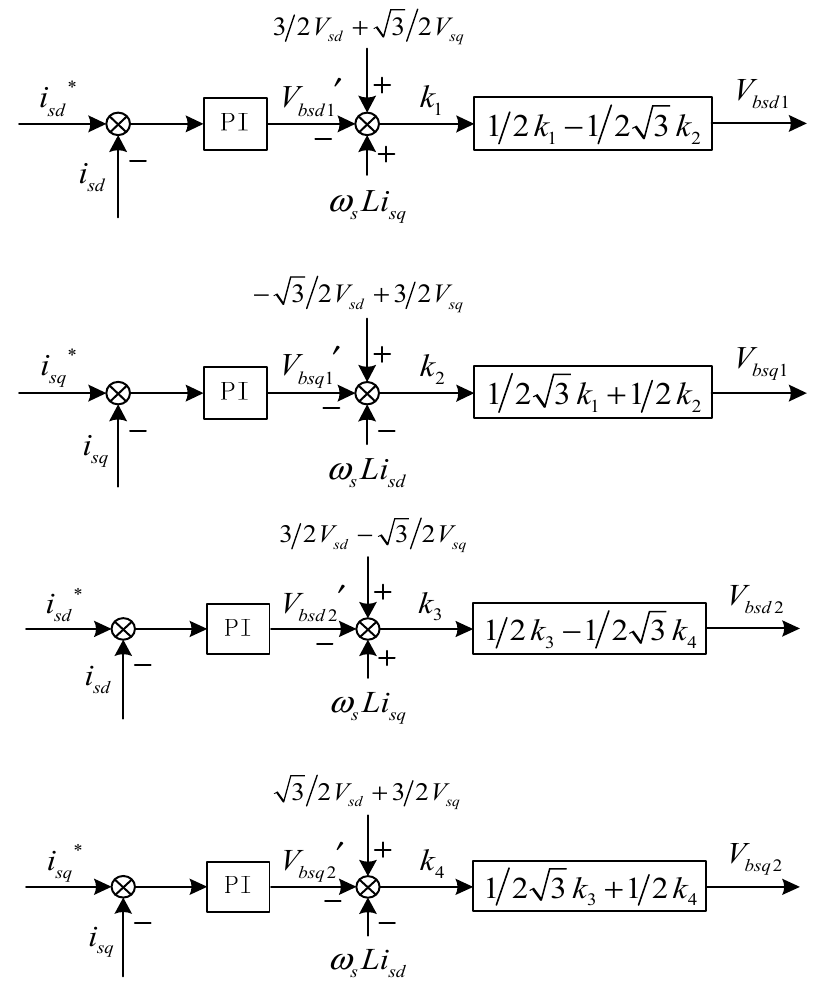
Figure 4. Control loop of PI controller for system 1.